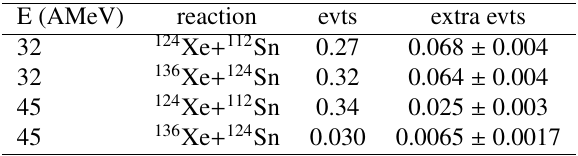
Table 1. Percentages of events and extra events with σ Z < 2 for the di ff erent incident energies and reactions. Calculated errors are statistical. From